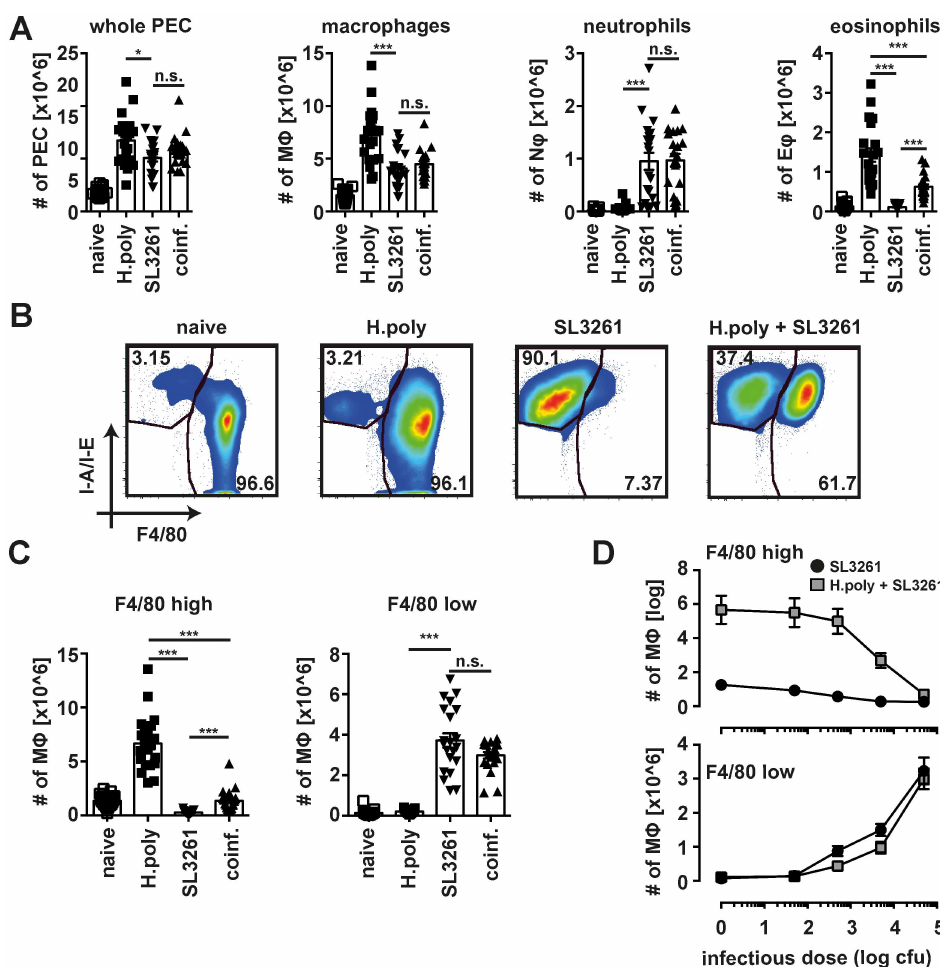
Fig 2. Bacterial co-infection triggers the disappearance reaction in helminth expanded M Φ . (A) Number of total peritonealexudate cells, M Φ , eosinophils and neutrophilsin uninfected(na ï ve)individually (SL3261and H.poly) or co-infectedmice (B) Representative dot plots depictingM Φ isolated in A. (C) Number of F4/80 high and F4/80 low M Φ from mice analysedin A. Data pooledfrom four separate experiments using 5–6 animalsper group. Datapointsdepict individualanimalsand bars indicatemean and SEM. (D) Number of peritonealF4/80 high and F4/80 low M Φ in single(black circles, SL3261)or co-infectedmice (grey squares, H. poly + SL3261)with the indicateddoses of SL3261. Animalsnot receivingbacterial inocula(na ï veand single H . polygyrus infection) are includedwith an arbitrary infectiondose of 1 CFU SL3261to allowdepictionon a log scale. Data pooledfrom two separateexperiments with 5 animalsper group each. * : p < 0.05; ** : p < 0.01, *** ; p < 0.001;n.s.: not